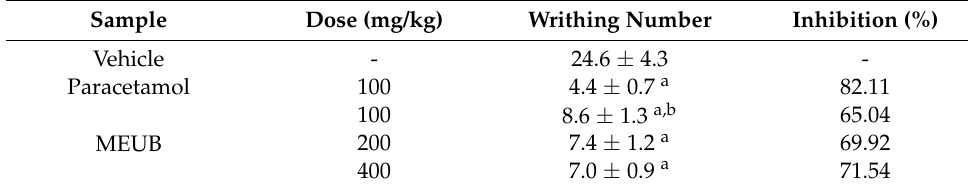
Table 4. Effects of MEUB on acetic acid-induced mice by i.p . route ( n = 5).